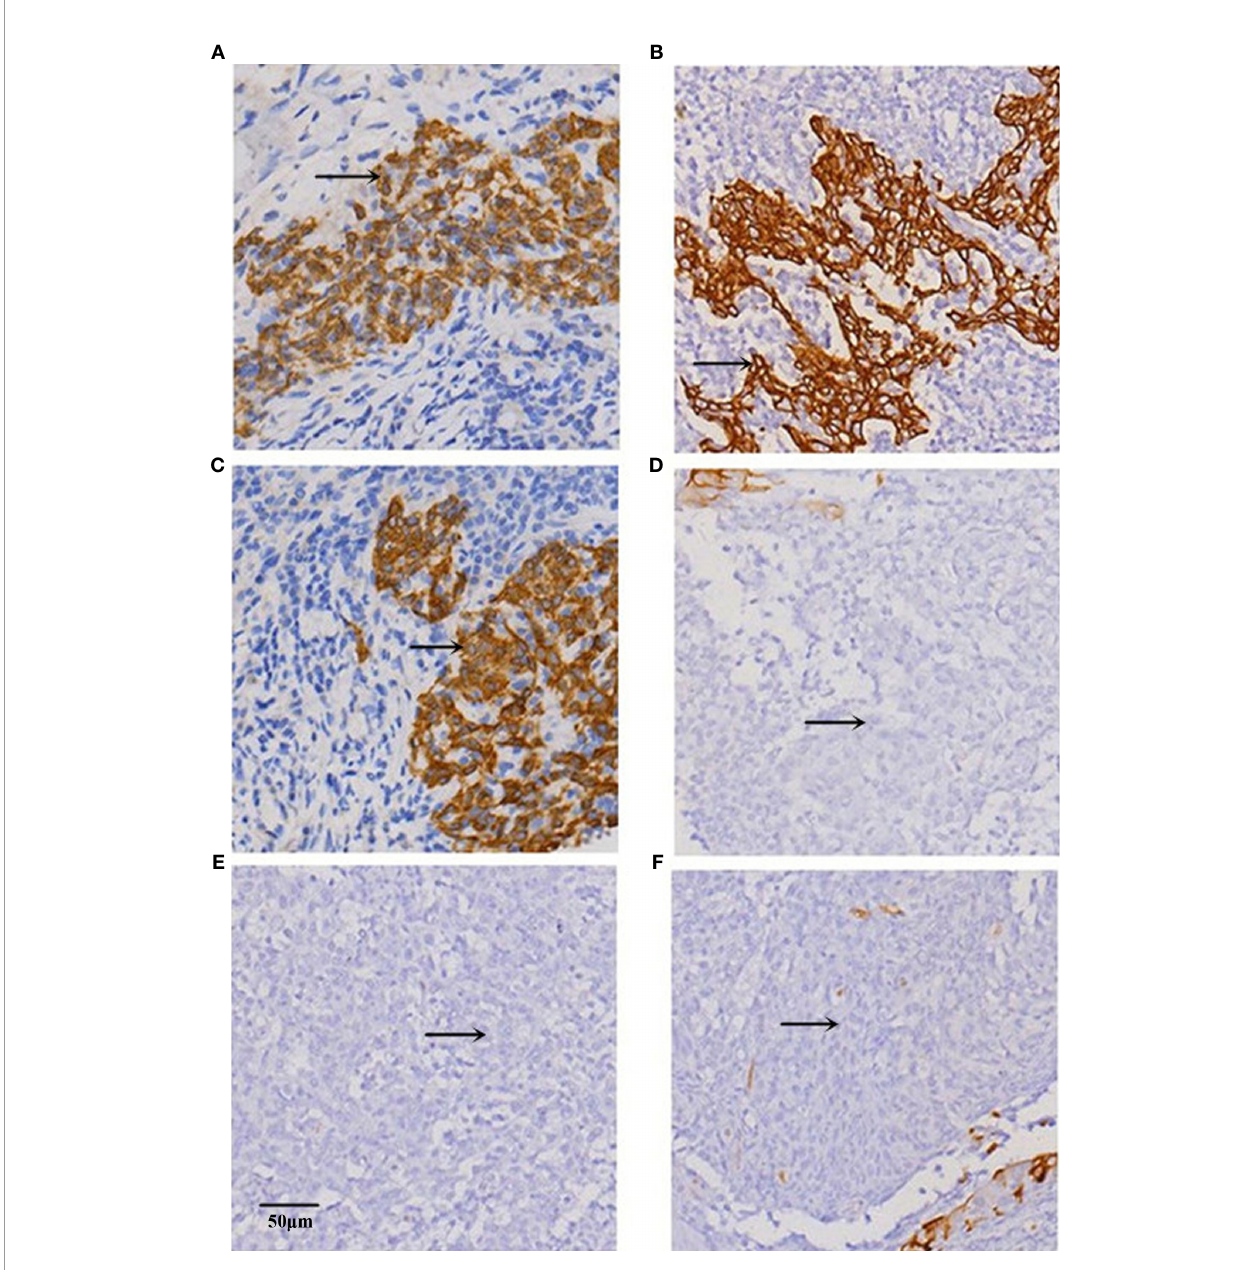
FIGURE 1 | Representative images of immunohistochemical staining for (A, B) MACC1, (C, D) E-cadherin, and (E, F) vimentin proteins in the (A, C, E) high and (B, D, F) low expression groups of NPC tissues at x200 magni fi